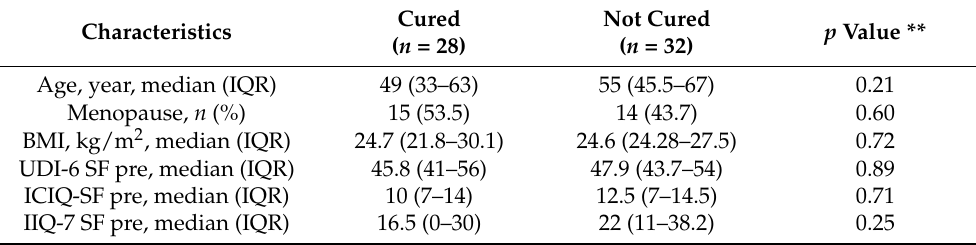
Table 5. Univariable analyses of variables potentially involved in the risk of FMS failure for SUI. Characteristics